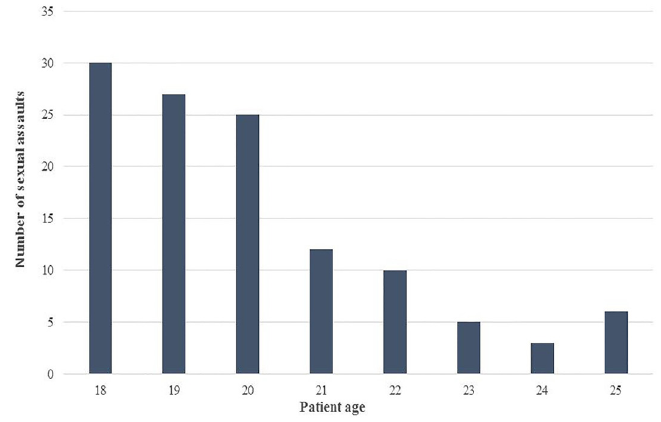
Figure 1. Number of sexual assaults by age among emerging adults.